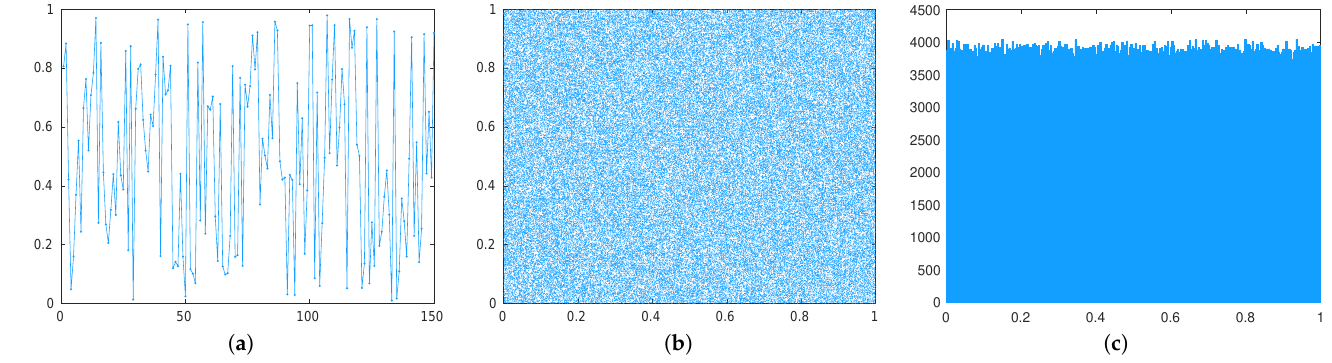
Figure 4. ( a ) Times series plot of { s i } 150 , ( b ) plot of the points ( s i − 1 , s i ) where 2 (cid:54) i (cid:54) 125,000, i = 1 ( c ) histogram of { s i } (cid:96) , for (cid:96) = 10 6 . i = 1